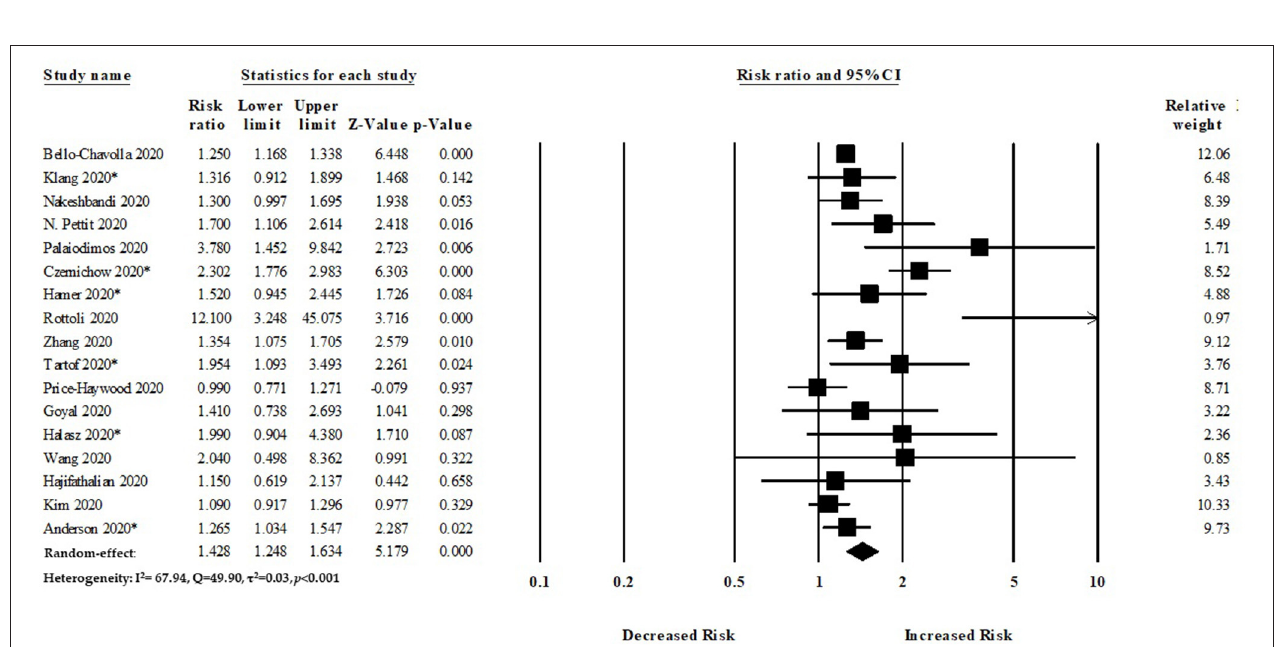
FIGURE 3 | Association between obesity and risk of mortality among COVID-19 patients.